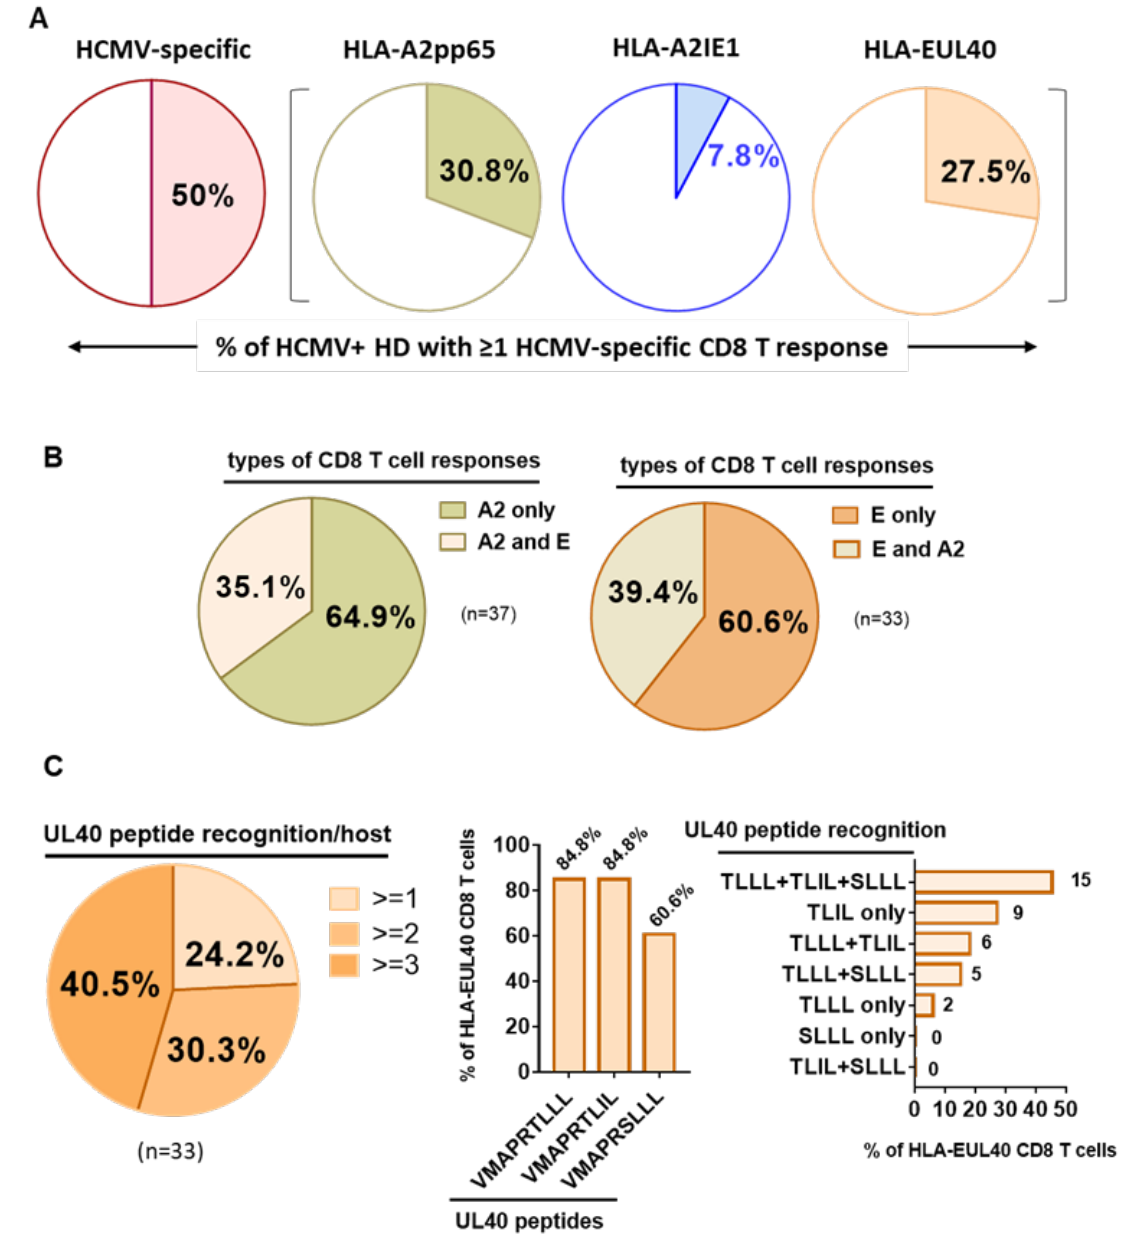
Figure 1. Detection and frequency of HLA-A2pp65, HLA-A2IE1 and HLA-EUL40 HCMV-specific CD8 T cells in HCMV+ HD. Pie charts indicating the percentages of HCMV+ HD with HCMV-spe- cific CD8 T cells detected. A single PBMC sample per donor was used for the concomitant detection of HLA-A2pp65, HLA-A2IE1 and HLA-EUL40 CD8 T cells. For the detection of HLA-EUL40 CD8 T cells, three HLA-E tetramers loaded with three different peptides (VMAPRTLLL, VMAPRTLIL and VMAPRSLLL) corresponding the most frequent UL40 variants were used in parallel experi- ments. ( A ) Percent of hosts ( n = 120) with at least one type of CD8 T cell response (all, A2pp65, A2IE1 or EUL40). ( B ) Percent of hosts with only an A2pp65 response or with both A2pp65 and EUL40 CD8 T cell responses among hosts with A2pp65 response ( n = 37, left panel) and with only an EUL40 response or with both A2pp65 and EUL40 CD8 T cell responses among hosts with EUL405 response ( n = 33, right panel). ( C ) Analysis of HLA-EUL40 CD8 T responses ( n = 33) in hosts showing the number (left panel), sequences (medium panel) and combinations (right panel) of UL40 peptide recognition.